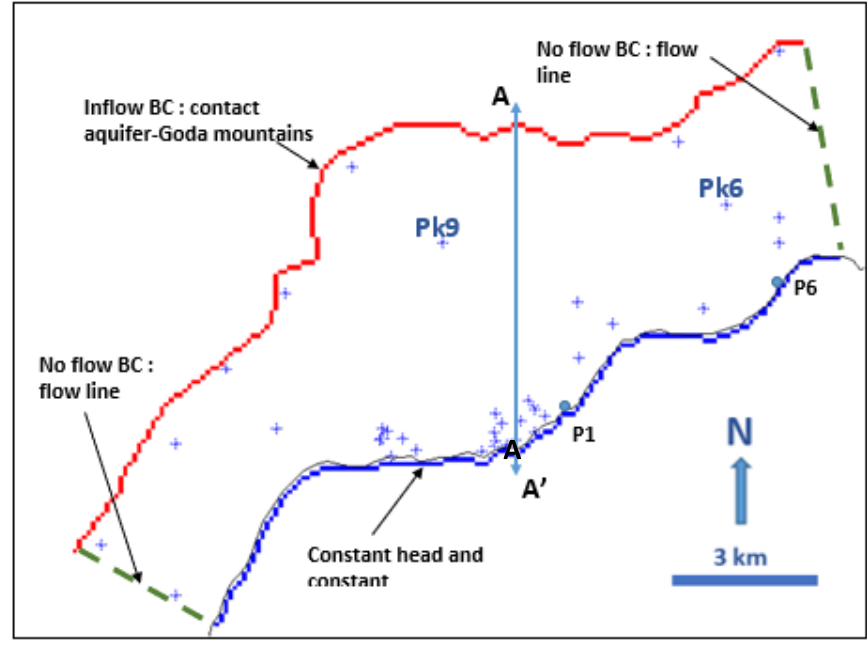
Figure 7. Boundary conditions of the numerical model of Tadjourah aquifer.